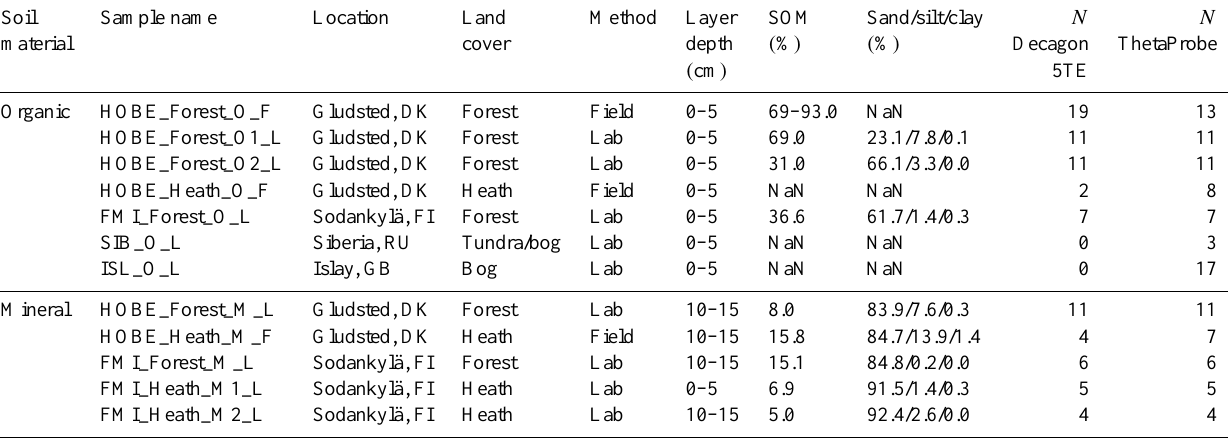
Table 1. Overview of the samples used for calibration. The sample name starts with the study site, followed by land cover type, soil material and indication whether used in laboratory or field calibration. O, M, F, and L denote organic, mineral, field, and lab, respectively. The letter specifying the soil material is complemented by a number if more than one sample of the same soil material is available at a given study site. N is the number of sensor measurements.